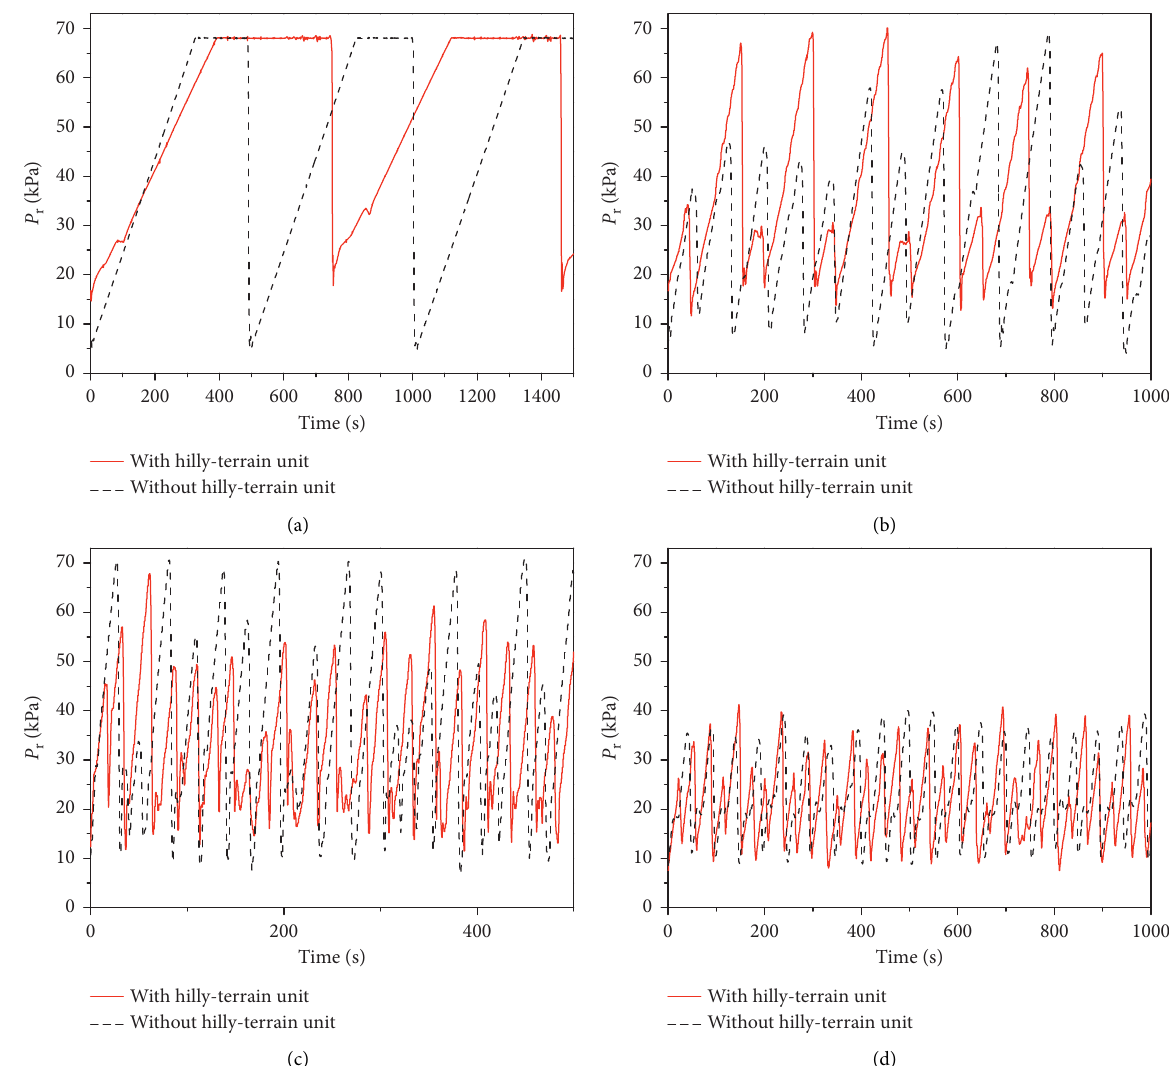
Figure 12: Comparison of P v � 0.371 m/s. (c) v sg